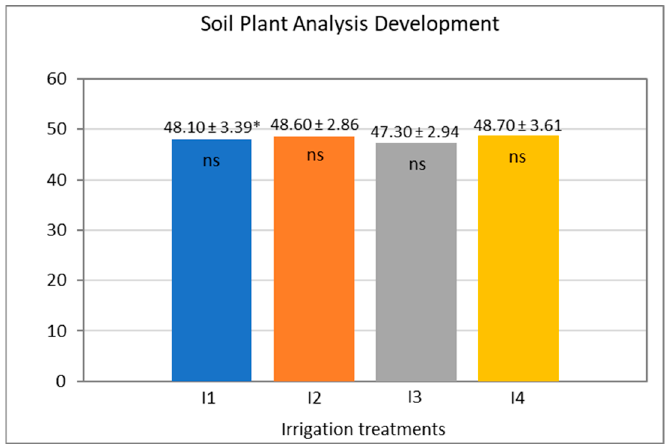
Figure 1. Intensity of green color of leaves (SPAD) of tomato cultivated under different irrigation conditions; * mean ± standard deviation; ns = not significant at p > 0.05 according to Tukey’s test.